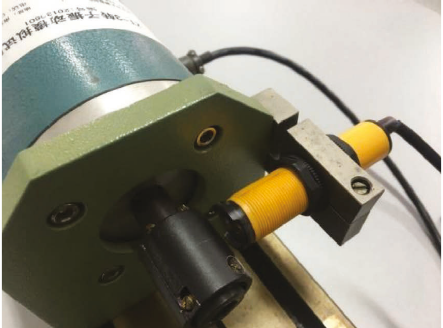
Figure 13: Rotating speed photoelectric encoder of test stand.